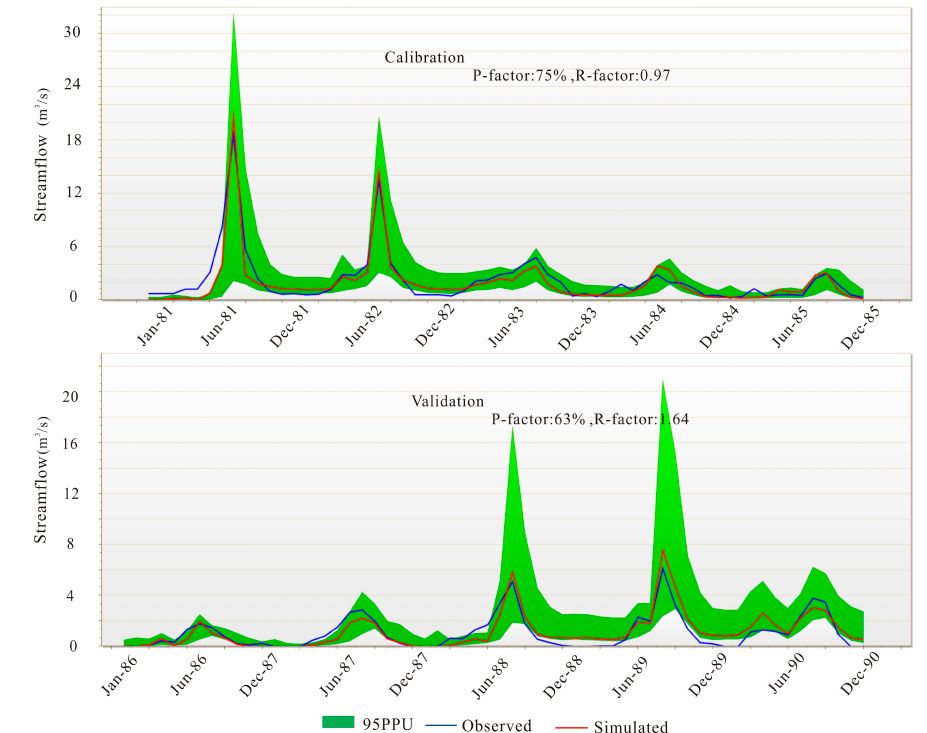
Figure 4. The results of SWAT-Calibration and Uncertainty Programs (SWAT-CUP) calibration and validation under Scenario 0 in the USK river basin.